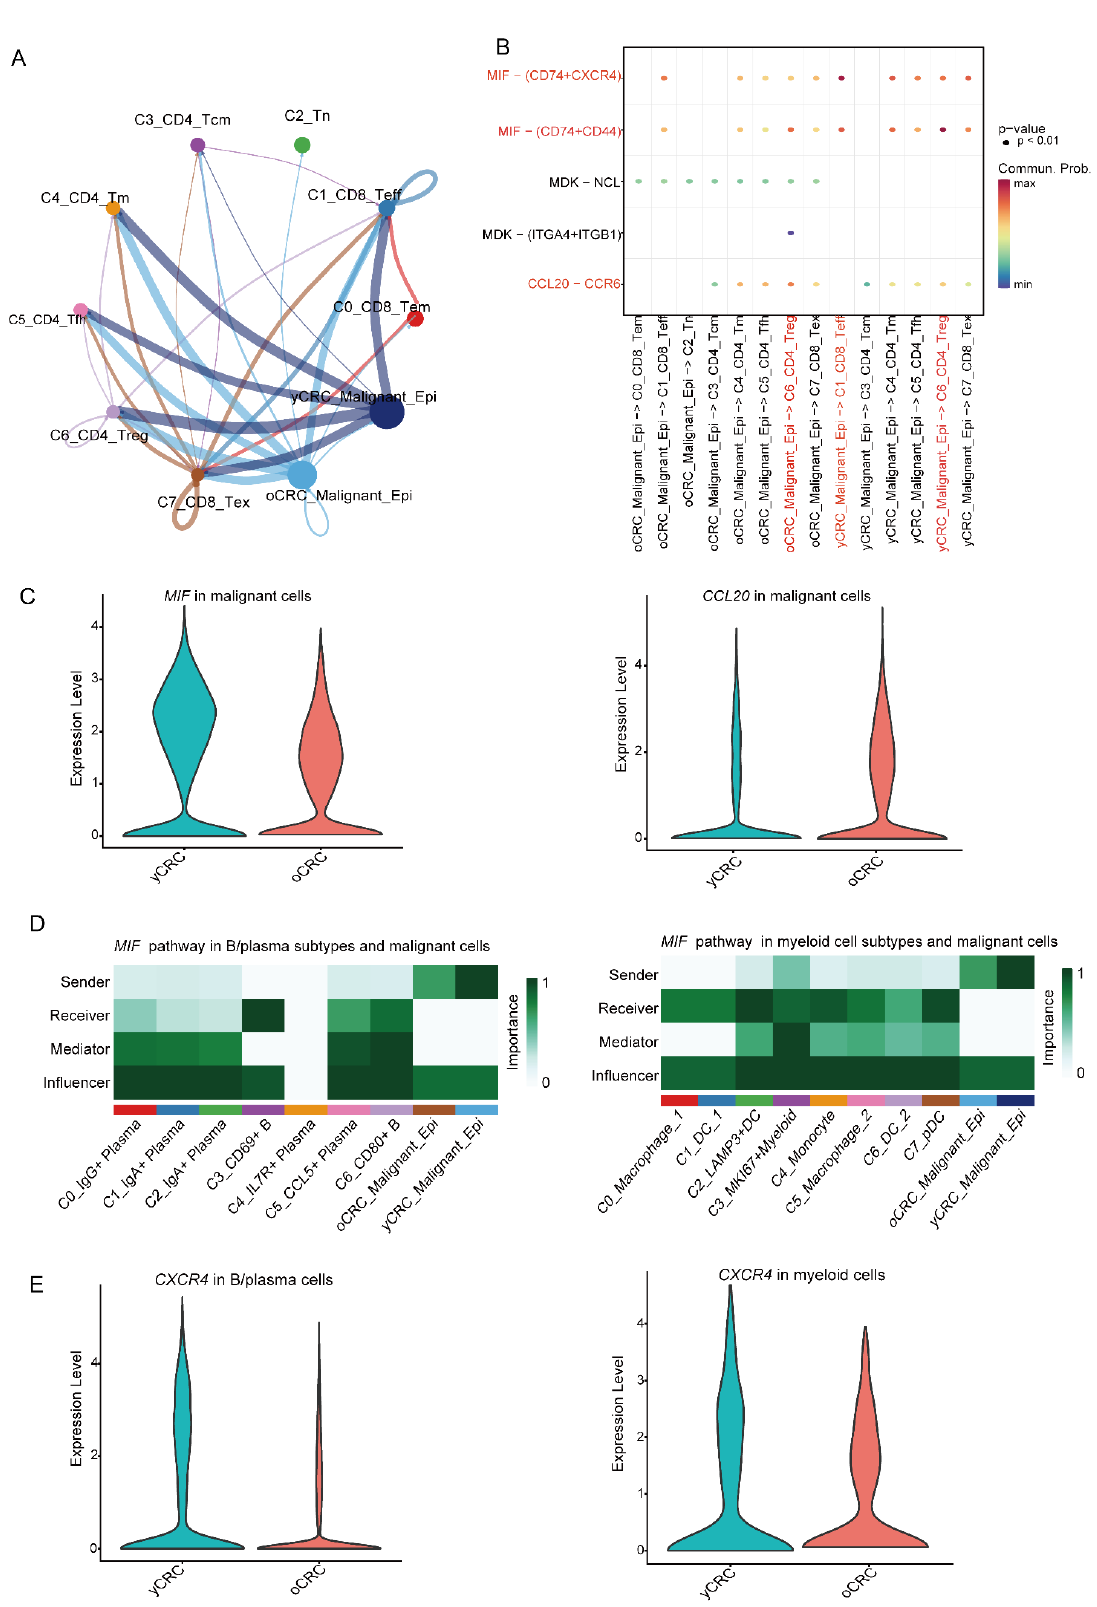
Figure 6. Heterogeneity of malignant cells and interactions with immune cells in the TME. ( A ) The strength network of inferred cellular interactions among T cell subtypes and malignant cells. ( B ) Ligand-receptor interaction probabilities of among T cell subtypes and malignant